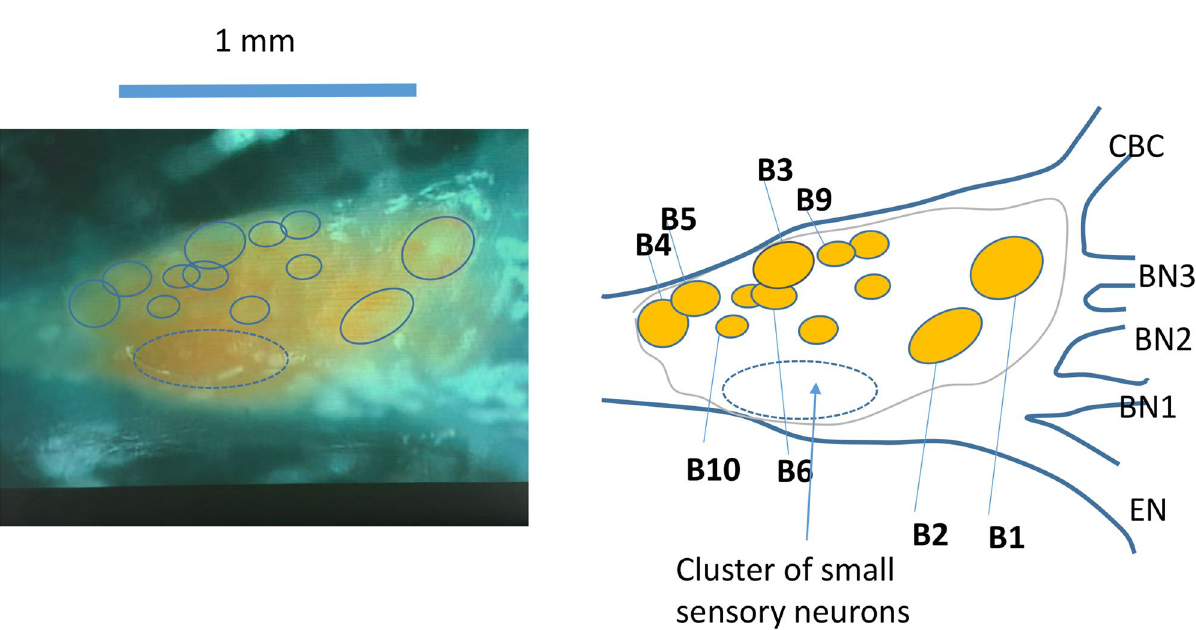
Figure 2. Anatomy of the buccal ganglion. Left picture shows one buccal ganglion. The right schematic was drawn based on the left picture. The picture and schematic together indicated the locations of several identified interneurons (B4 and B5), motor neurons (B3, B6, B9, B10) whose axons innervate buccal nerve 2 (BN2), and a cluster of small sensory neurons. EN: esophageal nerve. BN1: buccal nerve I; BN2: buccal nerve II. BN3: buccal nerve III. CBC: cerebro-buccal